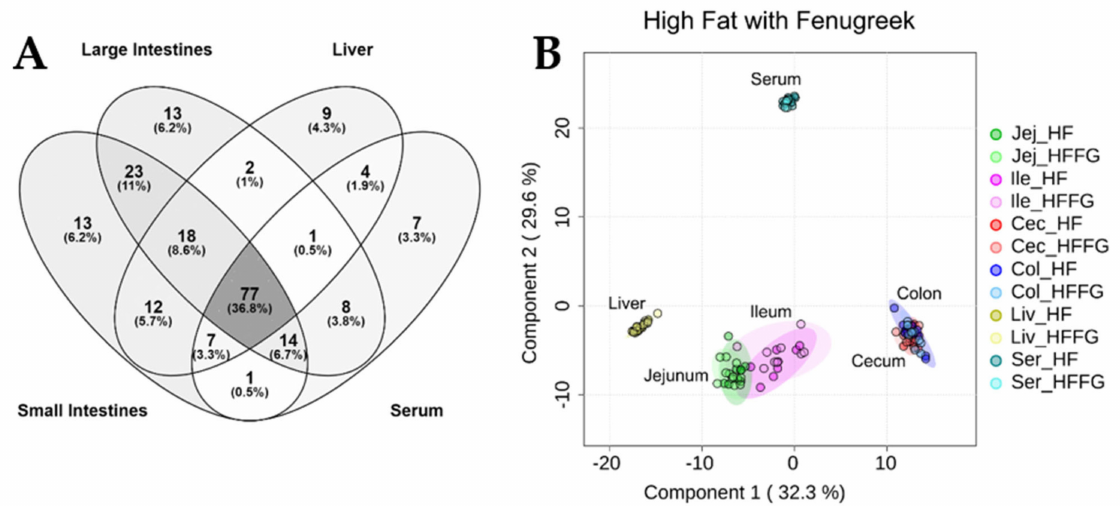
Figure 1. ( A ) Venn diagram depicting the overlap of identified metabolites between the small intestines, large intestines, liver, and serum. Of the identified metabolites, 36.8% were detected in all matrices; however, the least overlap was observed between large intestine, liver, and serum samples (0.5%) and between serum and small intestine samples (0.5%). ( B ) Partial least squares discriminant analysis (PLS-DA) comparing metabolomes associated with HF and HFFG diets for small intestines (jejunum and ileum), large intestines (cecum and colon), liver, and serum. Cross validation values can be found in Supplementary Table S1. Experimental replicates are shown with respective confidence intervals; HF and HFFG jejunum samples are dark and light green; HF and HFFG ileum samples are dark and light pink; HF and HFFG cecum samples are shown in dark and light red; HF and HFFG colon samples are shown in dark and light blue; HF and HFFG liver samples are dark and light yellow, and HF and HFFG serum samples are dark and light